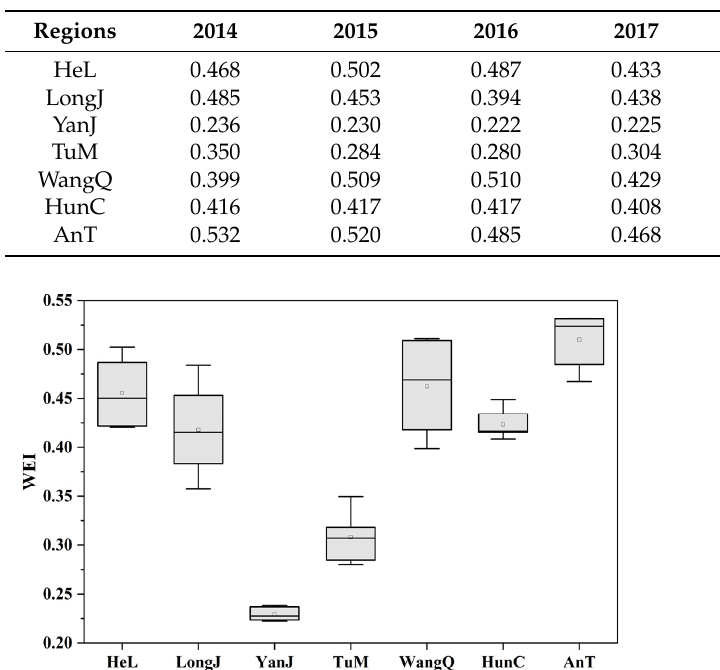
Table 3. The WEI for each region in the TRB from 2014 to 2019.